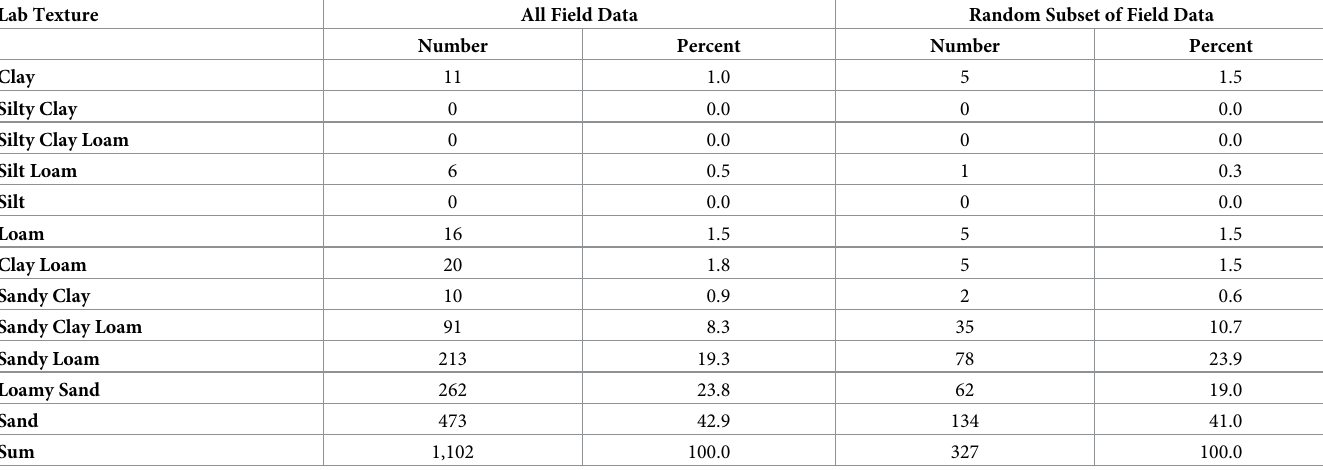
Table 2. Allocation of field samples among soil textural classes in the full field data set and the spatially uncorrelated random subset of field data. Lab